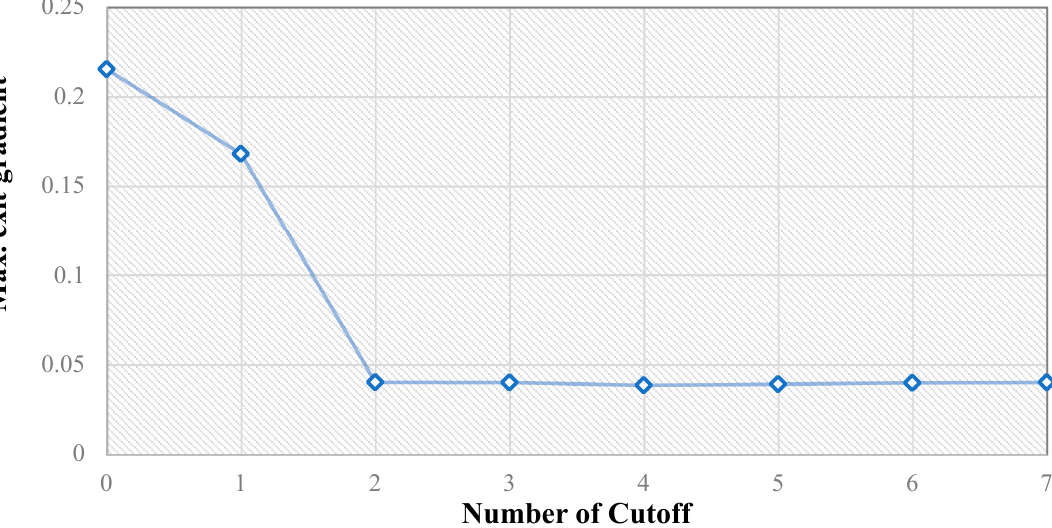
Figure 16. Maximum gradient of outlet discharge under the core for different numbers of grout curtains under the dam.